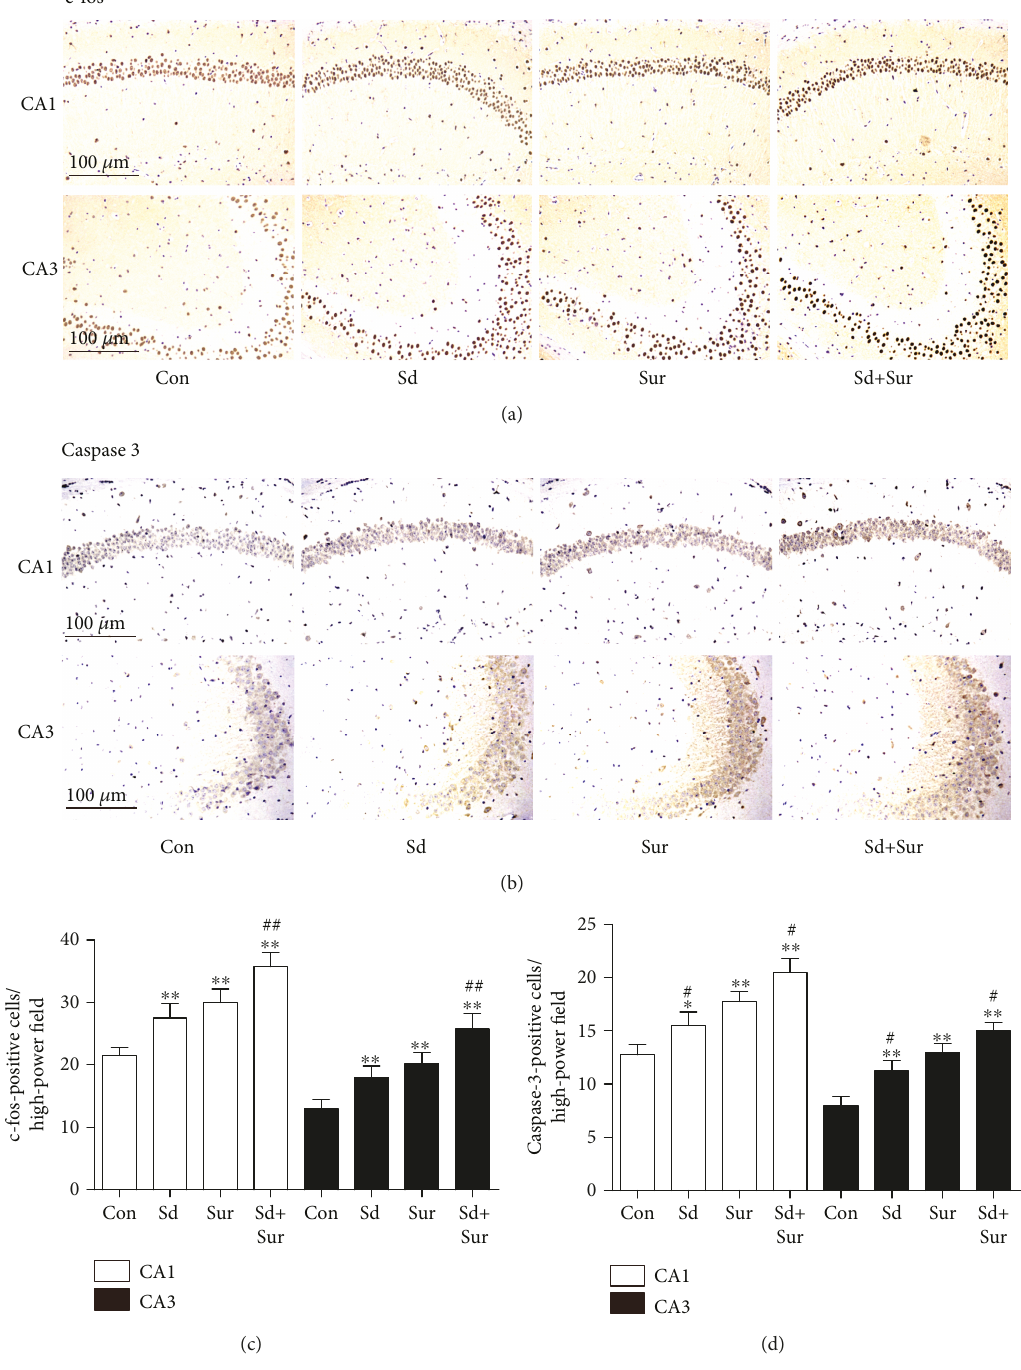
Figure 6: Preoperative sleep disturbance augmented surgery-induced neuronal activation and apoptosis in the hippocampus. (a, b) Representative immunohistochemistry images of neuronal damage based on staining with anti-c-fos and anti-caspsase-3 antibody in areas CA1 and CA3 of the hippocampus. Scale bar: 100 μ m. (c, d) Quanti fi cation of c-fos-positive and caspsase-3-positive cells in areas CA1 and CA3 of the hippocampus. The data are presented as the mean ± sem ( n = 4 ). ∗ P < 0 05 and ∗∗ P < 0 01 vs. the Con group; # P < 0 05 and ## P < 0 01 vs. the Sur